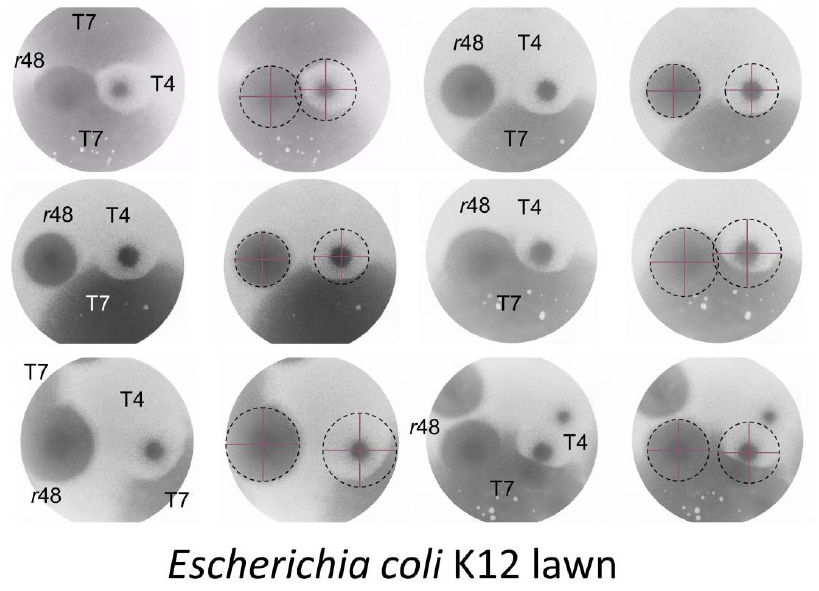
Figure 5. Various examples of collisions between individual plaques (not spots) of phage T4 wild type, the phage T4 r 48 mutant, and phage T7. Six di ff erent examples are shown, with the first and second columns identical across rows (three experiments) and the third and fourth columns also identical across rows (three additional experiments). Shown in the second and fourth columns are same-size (within-image) circles centered on the di ff erent T4 plaques. Phage T7 plaques are as labeled and are too large to be viewed in their entirety within a single field of view, as were photographed through the ocular lens of a dissecting microscope. Of interest is the intersection between the T7 plaque edges and these circles, which are suggestive of less visually obvious boundaries to the breadth of the zones of infection of T4 wild-type plaques. Note, though, that the T7 plaques invade the T4 wild-type plaques more deeply than do T4 r 48 plaques (Figure 4), that is, as heading towards the wild-type T4 plaque centers. This deeper invasion I interpret as being due to faster phage T7 plaque growth than that of phage T4, with T7 plaques thereby reaching the T4 wild-type-infected bacteria sooner, and therefore before the T4 plaques had grown fully in size. By contrast, we predict that wild-type T4 and r mutant plaques, as shown in Figure 4, would display more similar rates of ‘plaque’ growth. The conclusion proposed from this experiment is that the zone of infection for phages T4 r 48 and wild-type are similar in diameters. This figure is based on experiments equivalent to one originally published in Abedon [80], which is reprinted in the figure in part (lower-right), with permission from Nova Science Publishers, Inc. Plaques were generated by Cameron Thomas-Abedon and most of these examples are